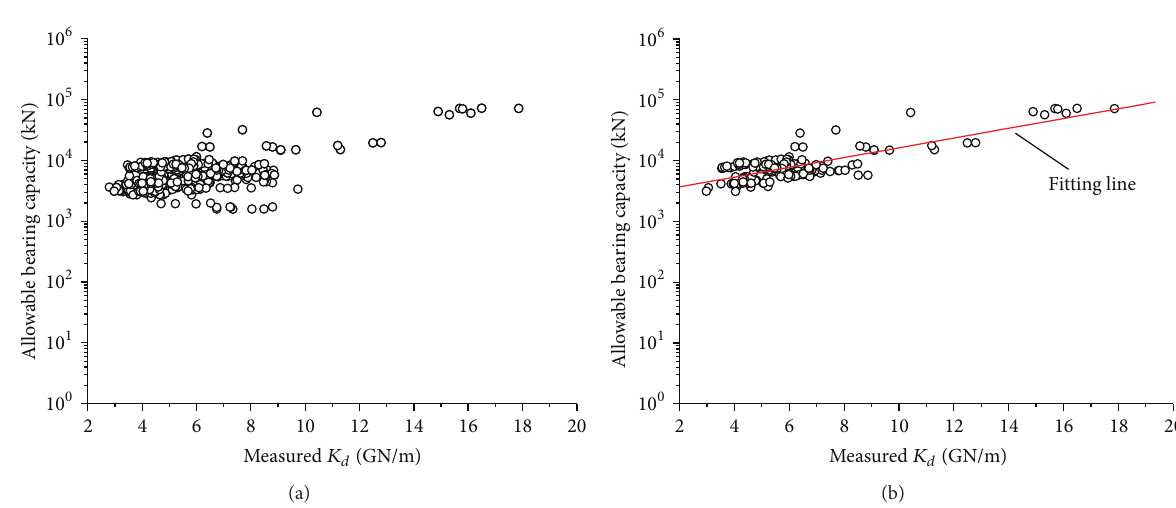
Figure 8: The relation between the dynamic stiffness and bearing capacity: (a) for all piles (680 samples) and (b) for typical intact piles (188